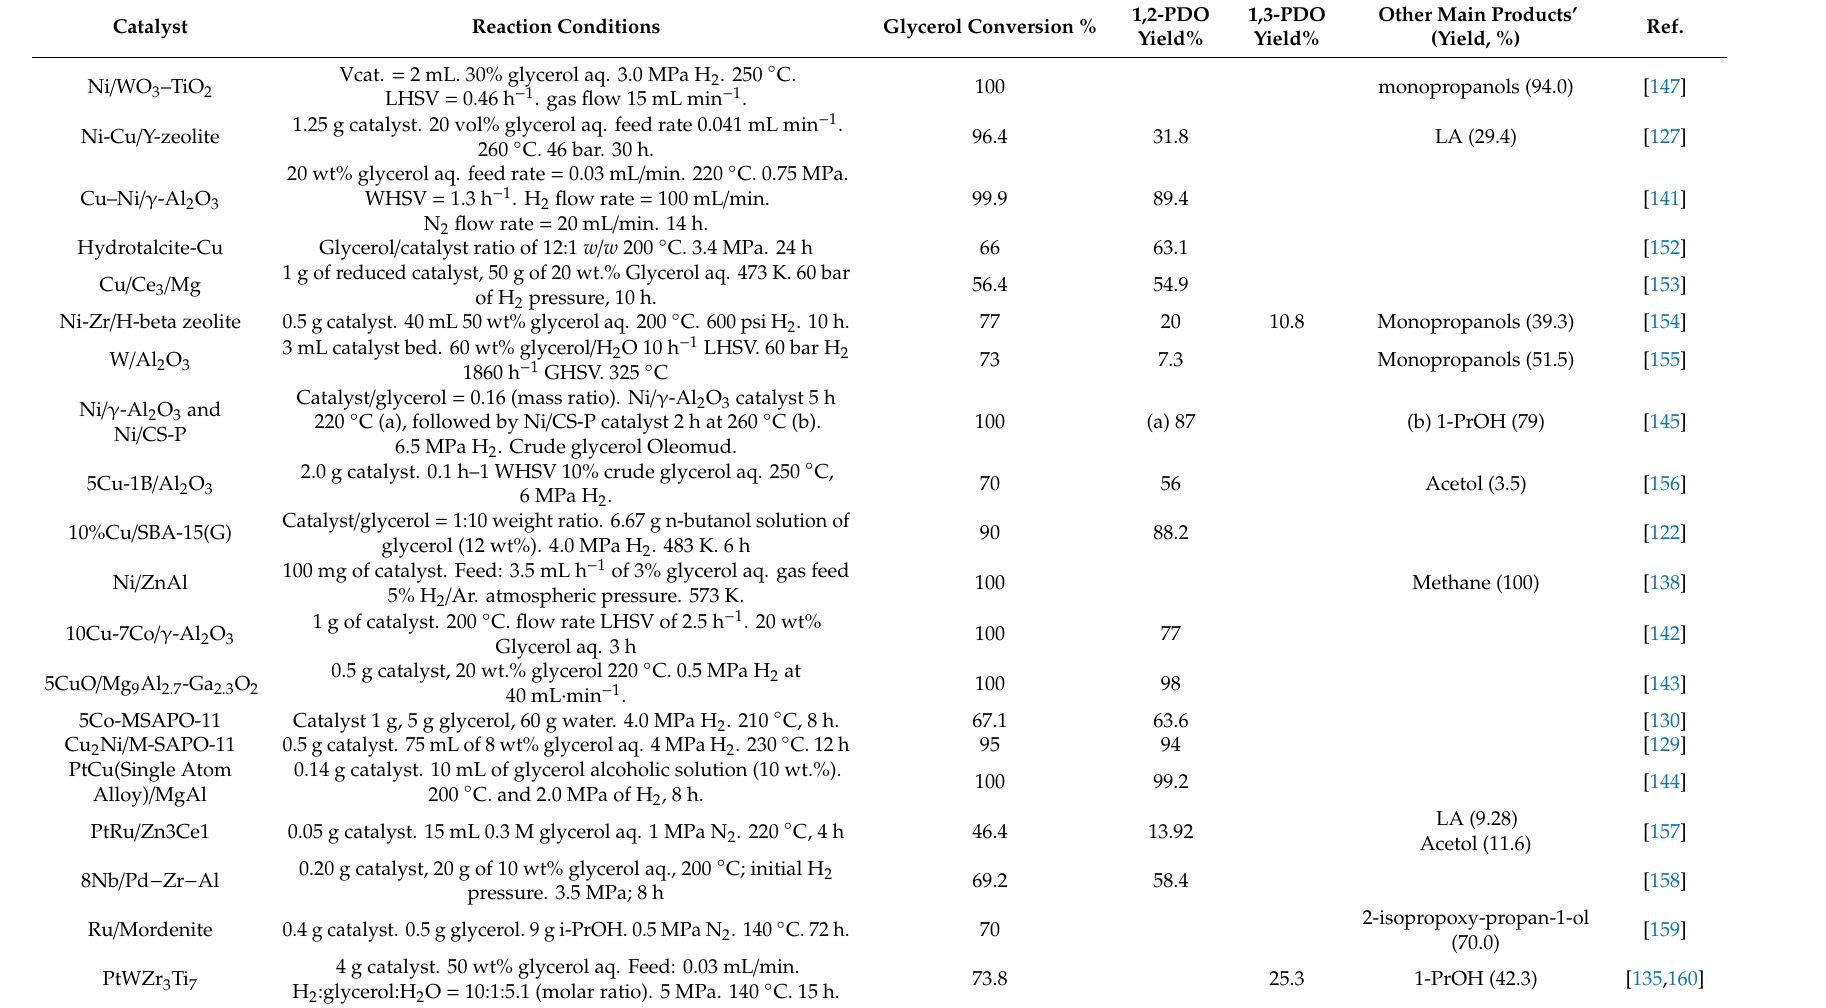
Table 5. Recent catalysts employed for glycerol